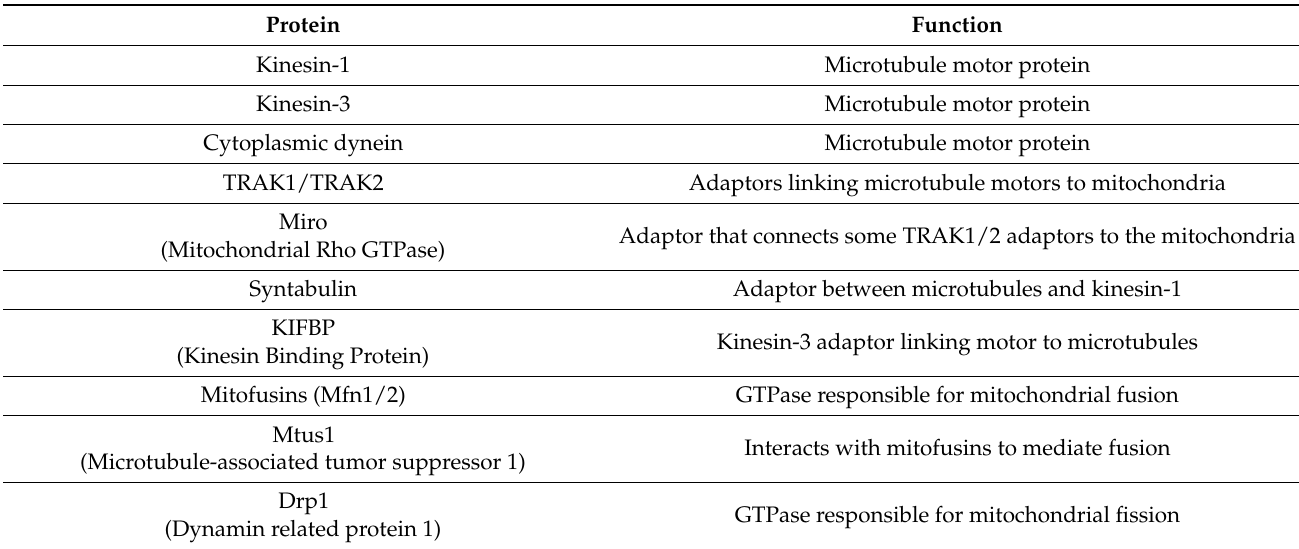
Table 1. Summary of mammalian proteins involved in microtubule-regulated fission, fusion, and motility described in this